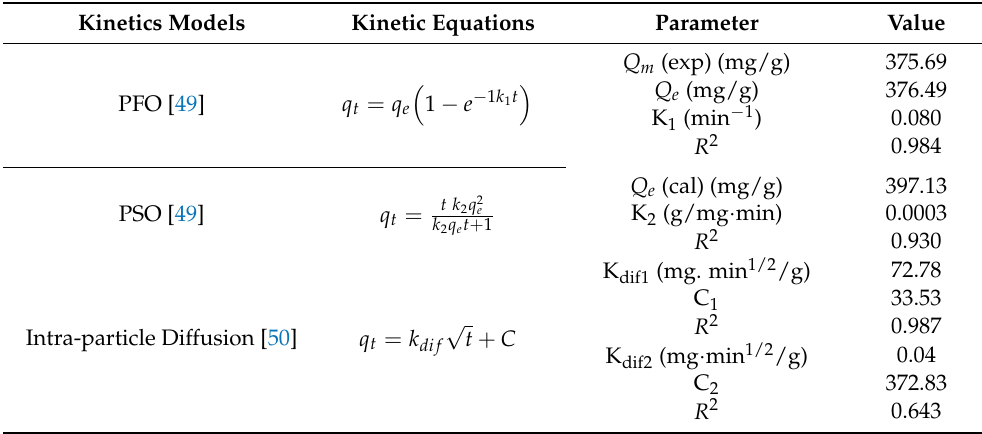
Table 2. Kinetics models for BF adsorption onto CaO-g-C 3 N 4